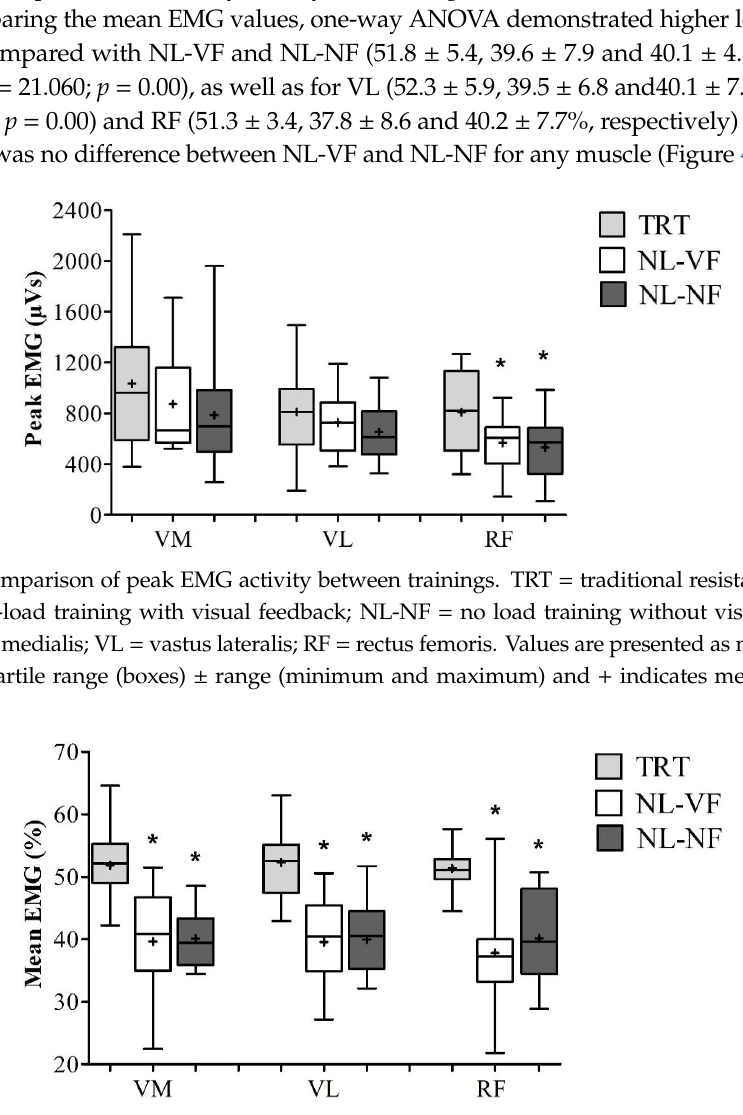
Figure 4. Comparison of mean EMG activity between different training protocols. TRT = load resistance training; NL-VF = visual feedback resistance training; NL-NF = no load resistance training; VM = vastus medialis; VL = vastus lateralis; RF = rectus femoris. Values are presented as median (lines) with interquartile range (boxes) ± range (minimum and maximum) and + indicates mean * p < 0.05 vs. TRT.